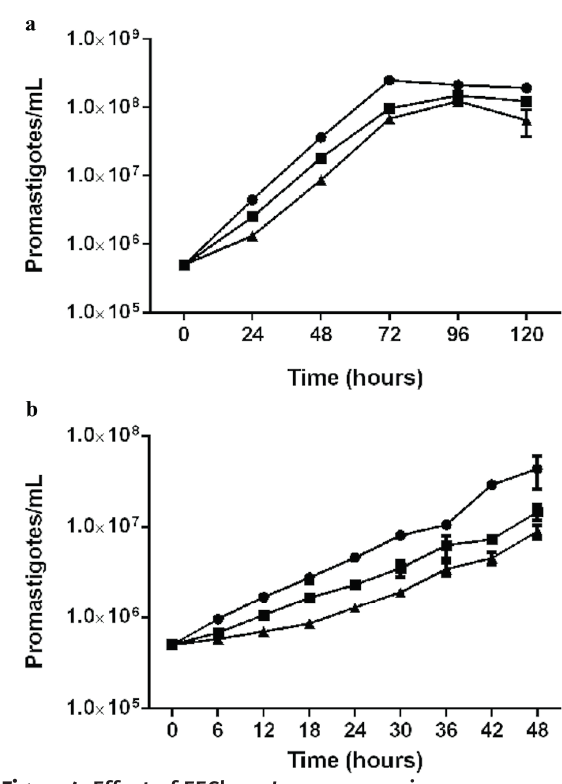
Figure 4. Effect of EECb on L. amazonensis promastigotes proliferation. L. amazonensis was cultivated in Schneider’s insect medium in the absence (circle) or presence of 70.0 µg/mL (square) or 140.0µg/mL EECb (triangle), and the number of parasites was determined by direct counting with a Neubauer chamber, every 24 h for 5 days (a), and every 6 h for 48 h (b). The doubling time was calculated by the Least Squares Fitting-Exponential method accessed in the online platform Doubling Time, available at http://www.doubling-time.com/ compute_more.php. Values are presented as the mean ± standard error of three different experiments in